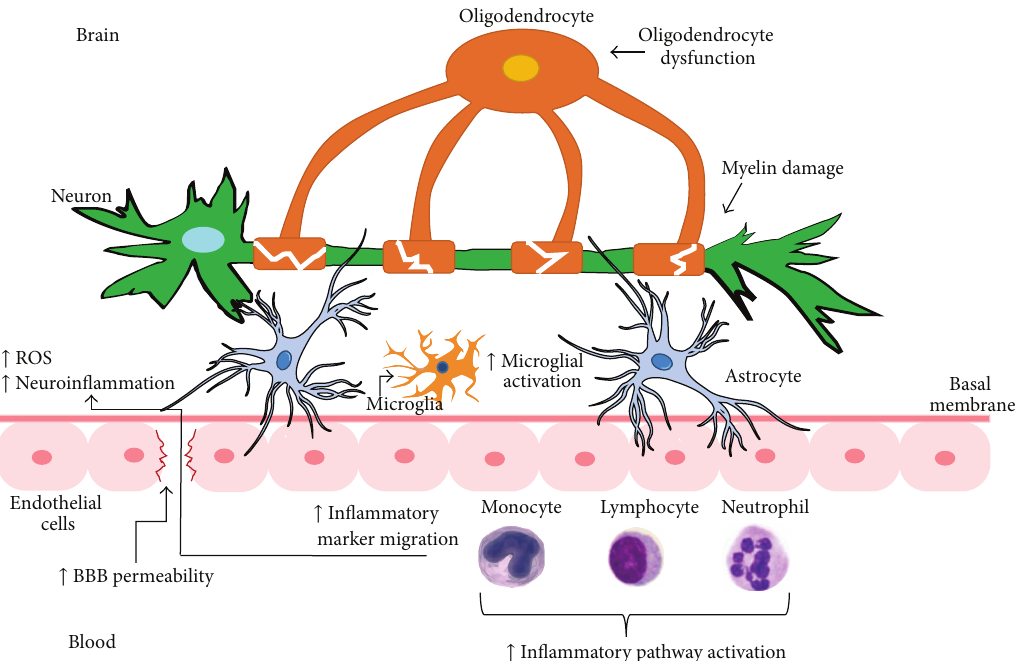
Figure 1: Proposed model of blood-brain barrier (BBB) disruption in bipolar disorder. Increased BBB permeability through the endothelial cells (pink) and basal membrane (dark pink) may facilitate increased migration of inflammatory molecules into the brain. Activation of microglial cells (light orange) and an increase in reactive oxygen species (ROS) would amplify neuroinflammatory processes and ultimately induce damage in the myelin sheath, either directly via lipid/protein oxidation or indirectly via oligodendrocyte dysfunction (dark